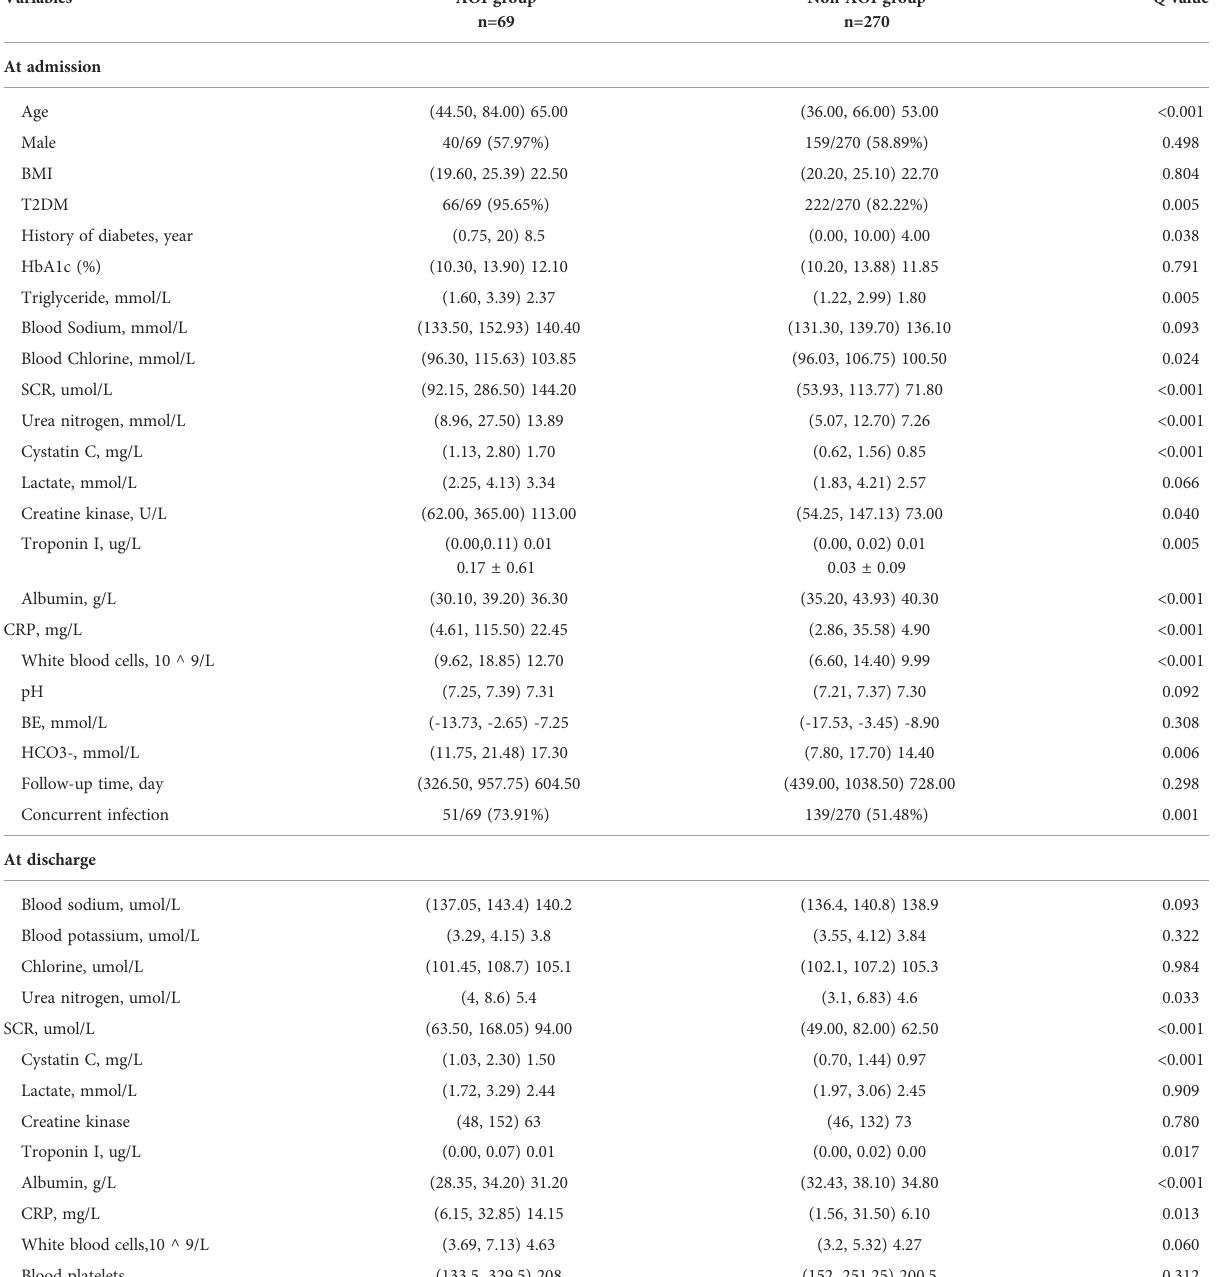
TABLE 1 Baseline characteristics of inpatients at admission or